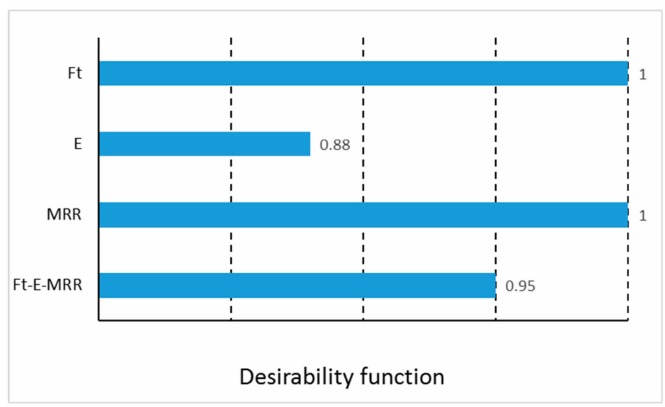
Figure 7. Desirability function.